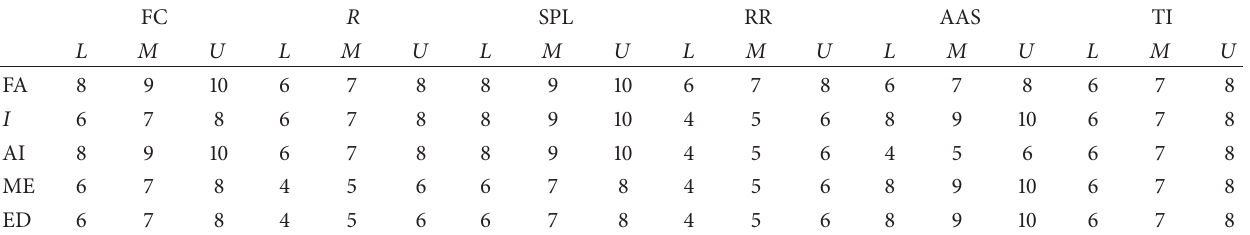
Table 11: Comparison for 𝑊 32 .